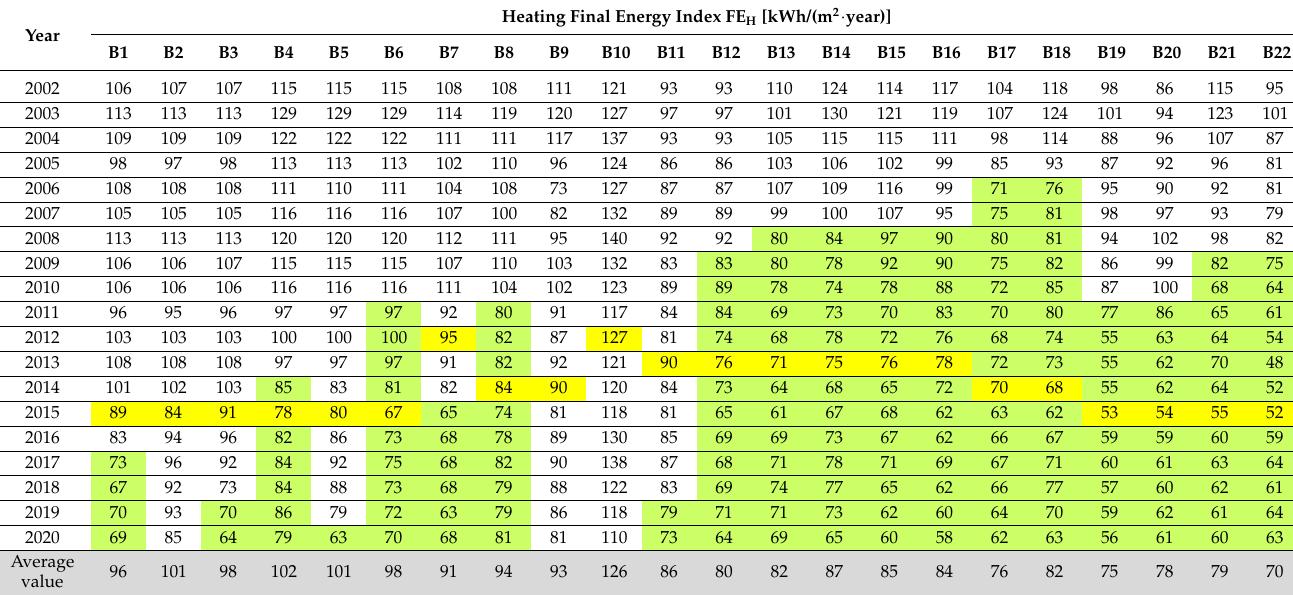
Table 4. Index of annual final energy demand FE H in the studied facilities B1–B22 from 2002 to 2020 [kWh/(m 2 · year)].